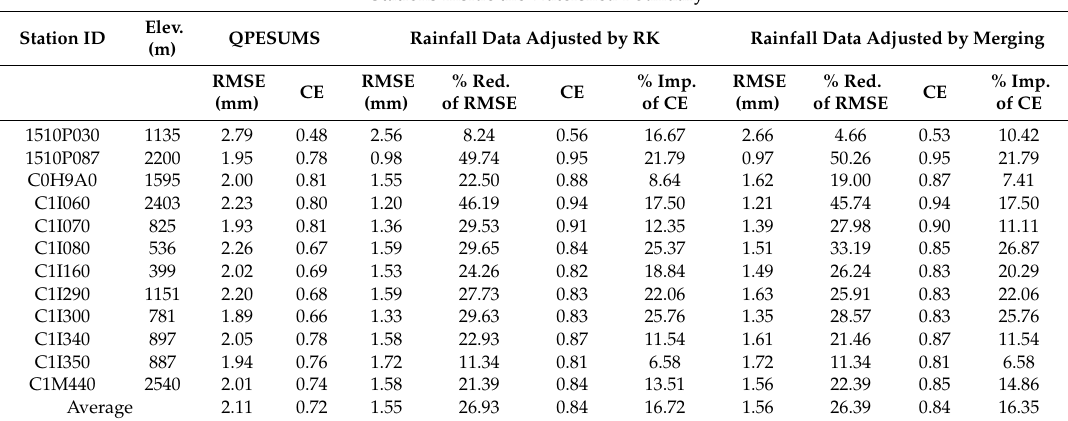
Table 1. Root mean square error (RMSE) and coe ffi cient of e ffi ciency (CE) for the unadjusted QPESUMS data and adjusted radar rainfall values using regression-kriging (RK) and merging for stations inside the watershed boundary during the event of Typhoon Kalmaegi. The values of the percentage reduction (% Red.) in RMSE, the percentage improvement (% Imp.) in CE, and the station elevation (Elev.) are also included.